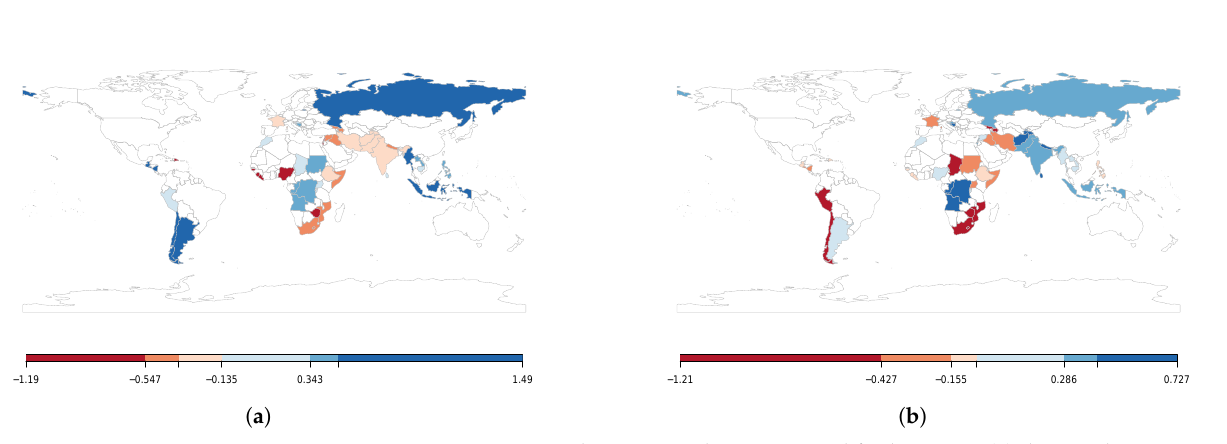
Figure 7. Post − war peace duration application spatial frailty maps: ( a ) depicts the posterior mean estimates of V (split − stage spatial frailties) and ( b ) depicts the posterior mean estimates of W (survival − stage spatial frailties).